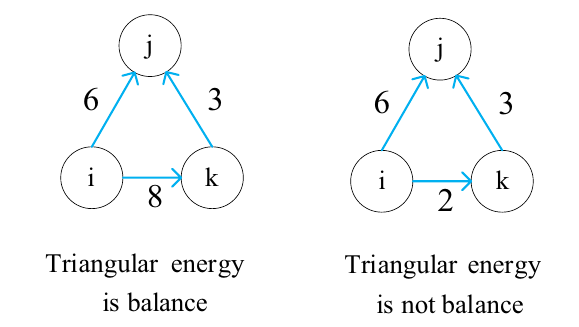
Fig. 3 Conservation of triangular